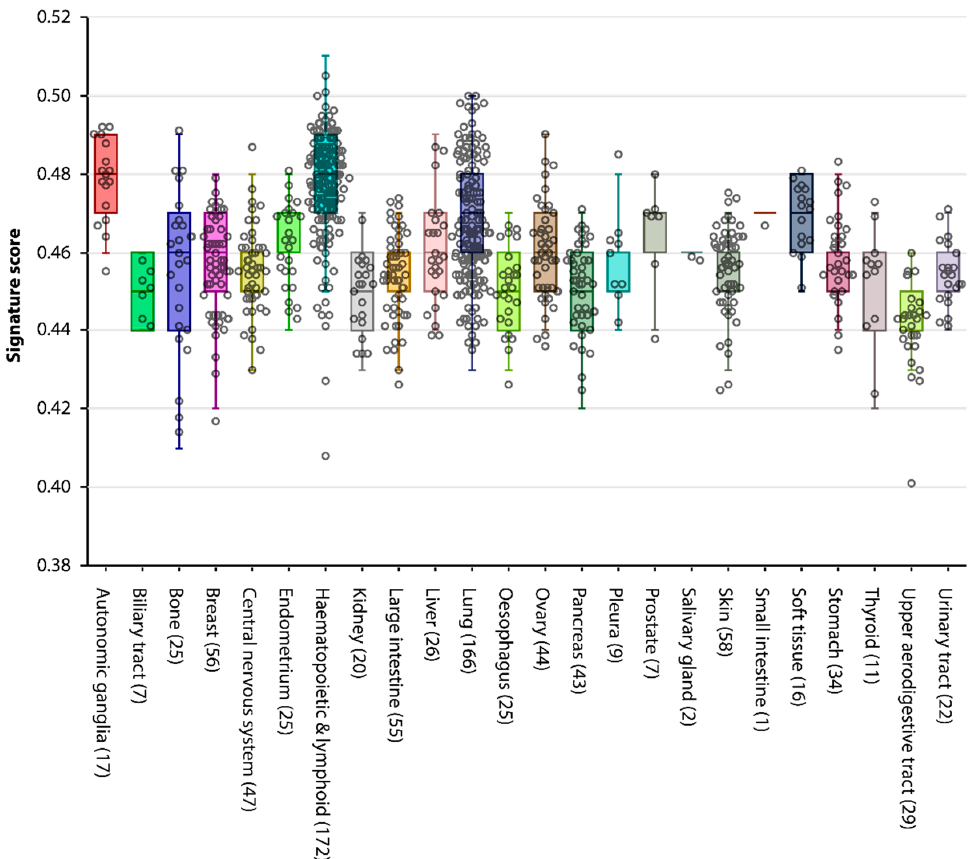
Figure 3. GC signature score in 917 cancer cell lines in the Cancer Cell Line Encyclopedia [27], based on all 1143 known GC genes. Every dot represents one cancer cell line. The signature score is the average percentile of ranked gene expression in each cell line, and may be used as a measure for a cancer cell line’s similarity to the germline.